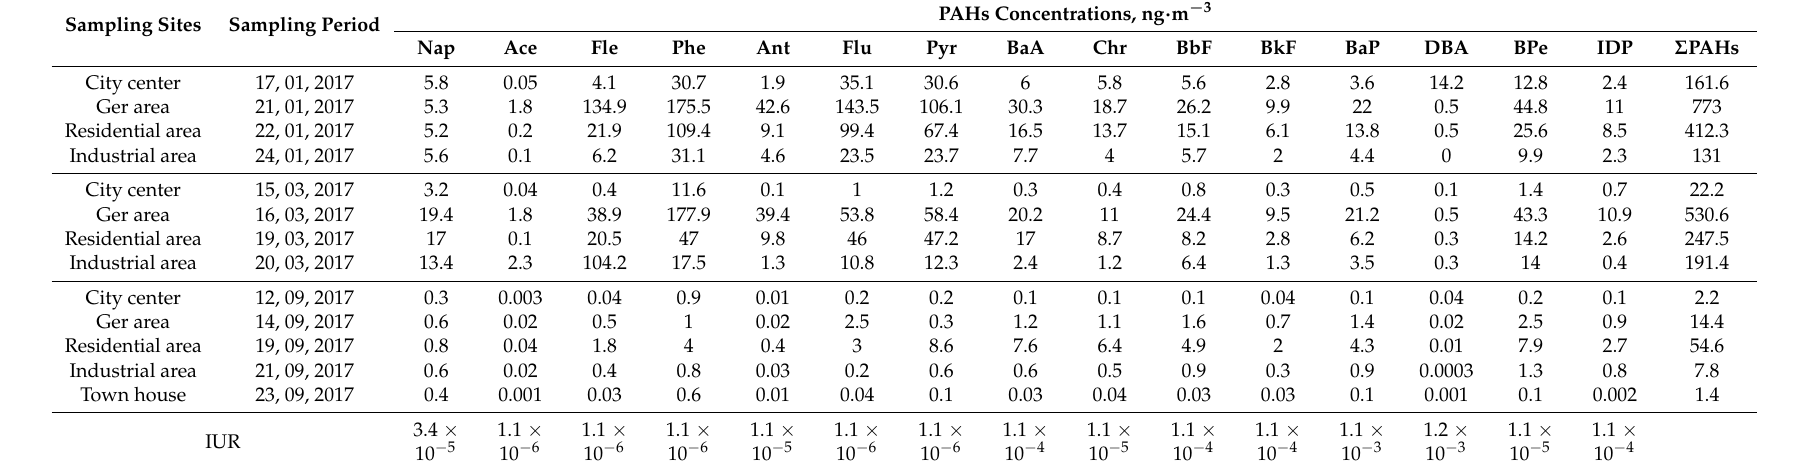
Table 4. The selected PAH species, concentrations, and groupings by molecular weight in the urban ambient air of Ulaanbaatar. Sampling Sites